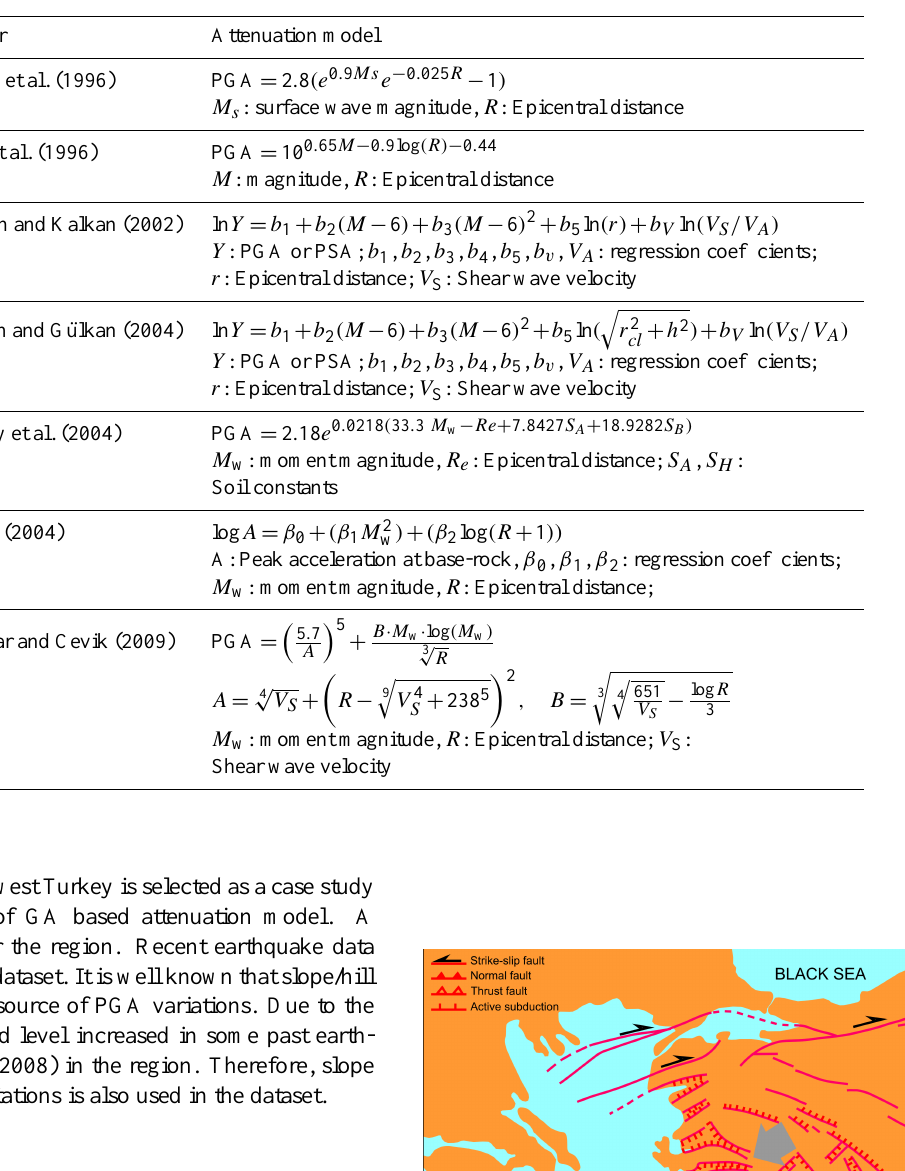
Table 1. Local empirical predictive relationships developed from Earthquakes in Turkey.